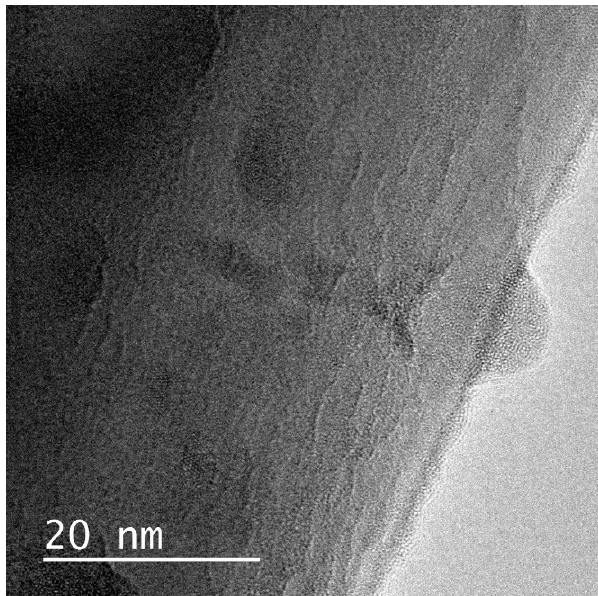
Figure 7. Bright field images of hillocks induced in Nb-doped SrTiO 3 irradiated with 200 MeV Au 32+ at an oblique incidence angle.